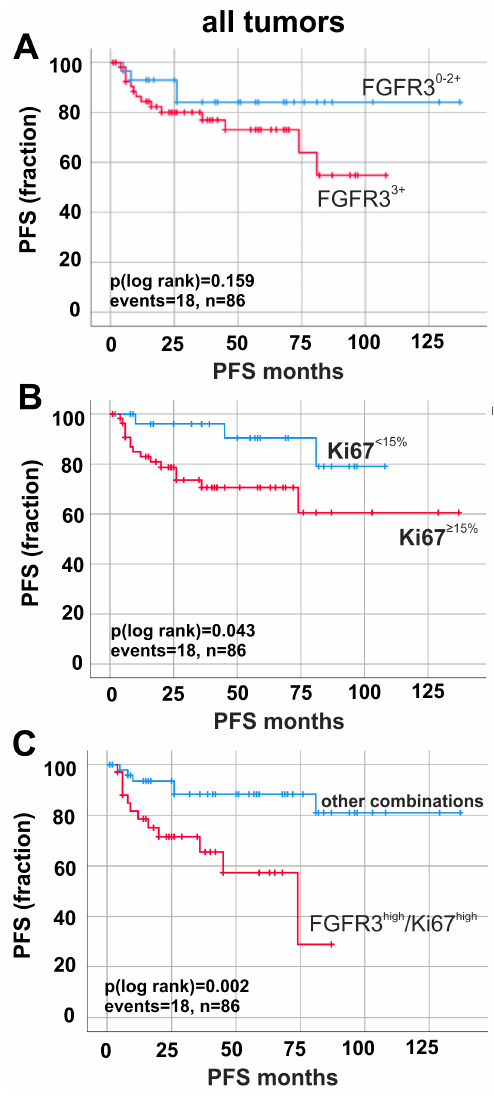
Figure 2. Prognostic impact of FGFR3 and Ki67 protein expression in all tumors (pTa, pT1 and pT2–4). Kaplan–Meier survival curves display progression-free survival (PFS). ( A ) Survival curves of patients with high FGFR3 expression (red curve, n = 56) compared to low FGFR3 expression (blue curve, n = 30). ( B ) Kaplan–Meier analysis of patients with high Ki67 expression (red curve, n = 56) compared to low Ki67 expression (blue curve, n = 30). ( C ) Survival curve analysis of FGFR3 high /Ki67 high expression (red curve, n = 34) compared to all other combinations of FGFR3 and Ki67 expression (blue curve, n = 32). n : overall number of cases; events: overall events of tumor progression.